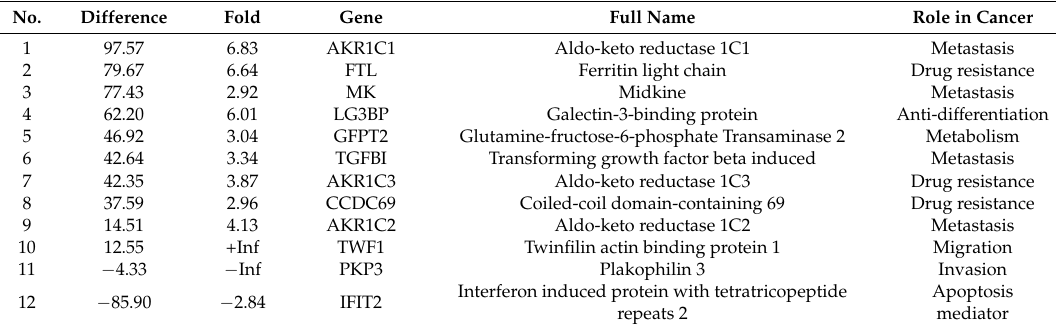
Table 1. Differentially expressed genes (DEGs) in MDA-MB-231/IR cells related to cancer resistance. DEGs are expressed in differences, fold changes (log2), with their